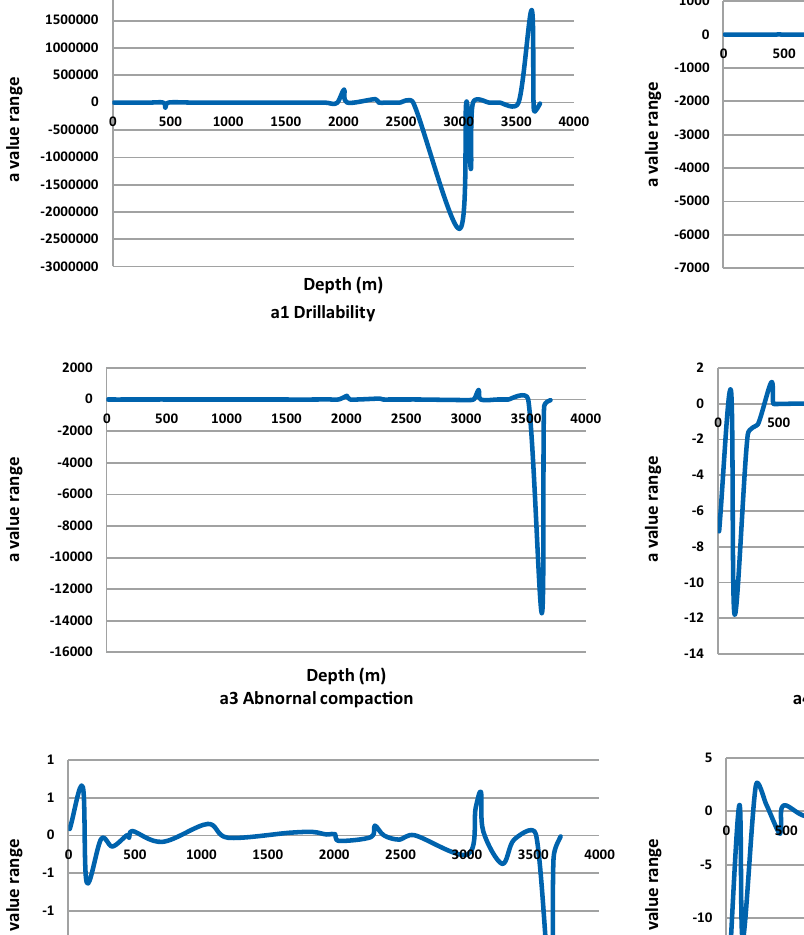
Fig. 9 Range values of coefficient constant a